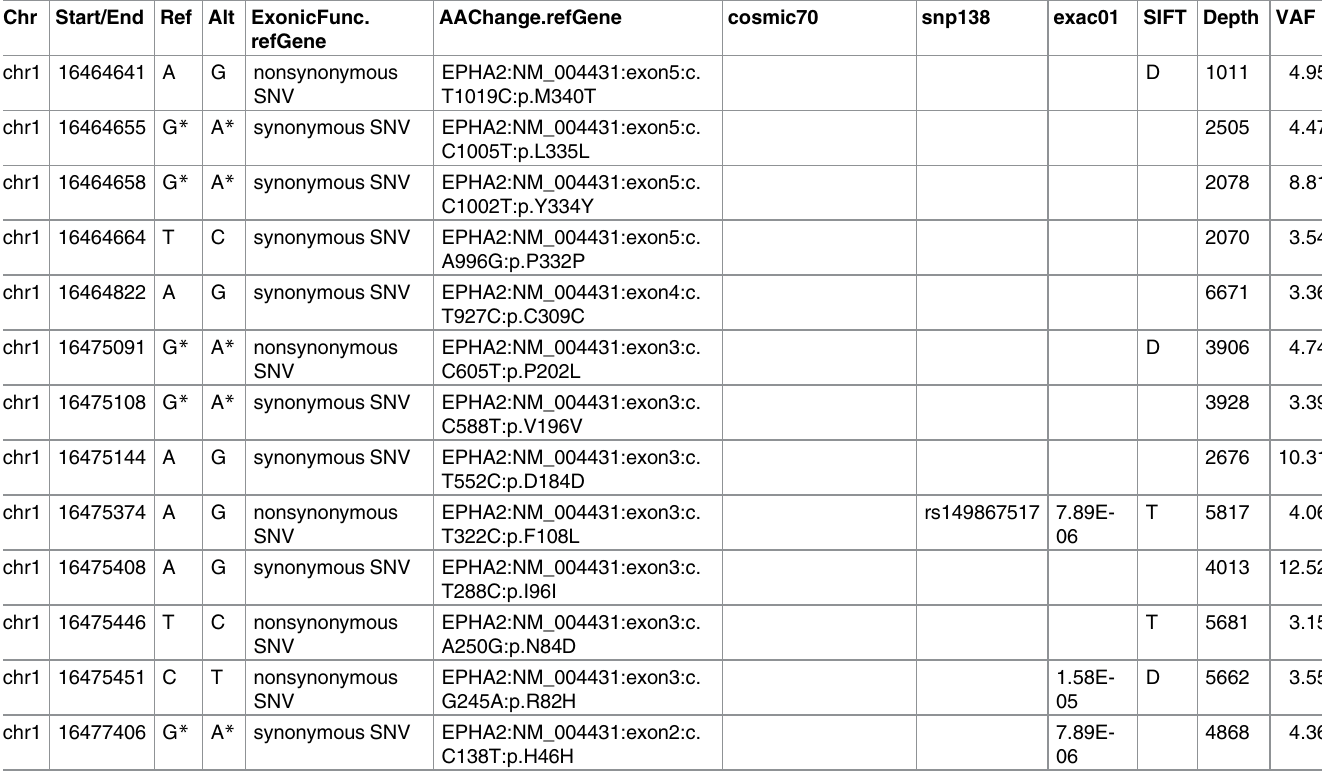
(Table 4). All 19 missense SNVs involved C/T or A/G transitions and 12 of these occurred at also occurred at UV-susceptible di-pyrimidine sites. Overall for EPHA2 , there was no signifi- cant difference between the paired clear lens panel and the paired cataract lens panel with respect to total SNVs ( p = 0.48), damaging SNVs ( p = 0.85), or novel SNVs ( p = 0.64) using Fisher’s Exact Test (S6 Table). Correcting for sex in the lens panels using logistic regression analysis did not provide any significant association for total EPHA2 SNVs ( p = 0.62), damaging